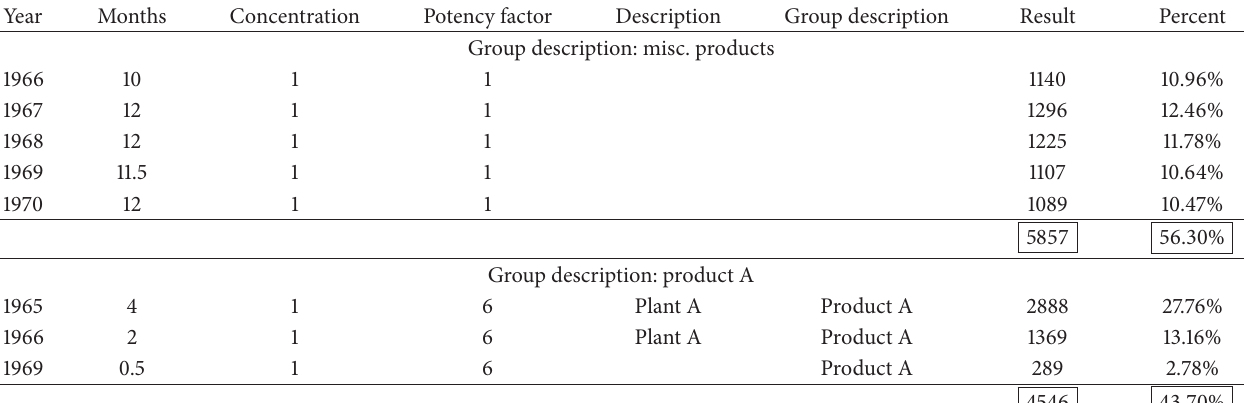
Table 1: Print out. Mesothelioma year diagnosis: 2013.